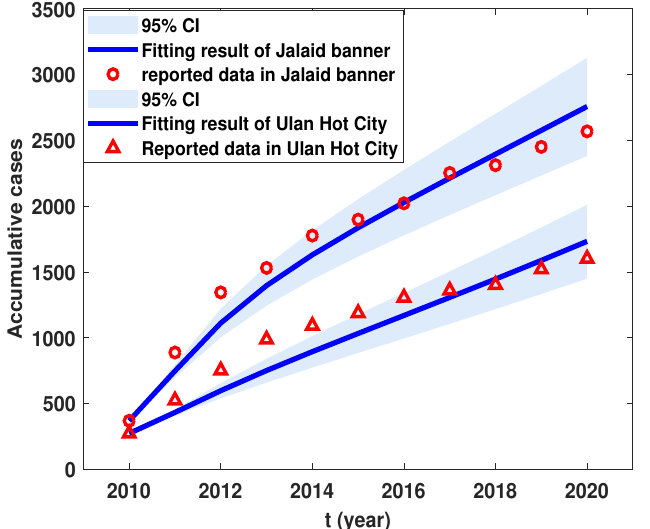
Figure 4. Fitting results of cumulative new cases from 2010 to 2020 in Jalaid banner and Ulanhot City. The circles and triangles are the number of cumulative newly reported human cases, and the curve represents the solution of the